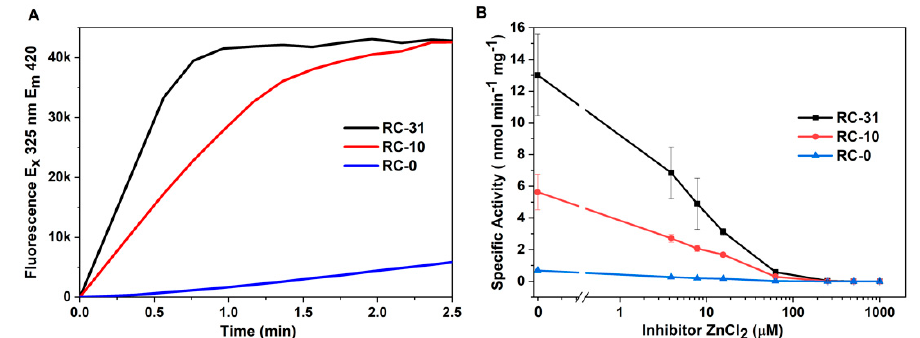
Figure 4. FRET cleavage and inhibitor assays for OmpT in three refolding buffers containing different concentrations of detergent, RC-31, RC-10, and RC-0. ( A ) Change in fluorescence emission intensity due to cleavage of FRET-peptide by OmpT. (B) Protease activity measurements in the presence of increasing inhibitor (ZnCl 2 ) concentration and plotted as specific activity vs. inhibitor concentration. Note: To avoid the 0 value on the X -axis of the semi-logarithmic plot in ( B ), the specific activity corresponding to 0 μ M ZnCl 2 was plotted as 0.01 μ M ZnCl 2 .